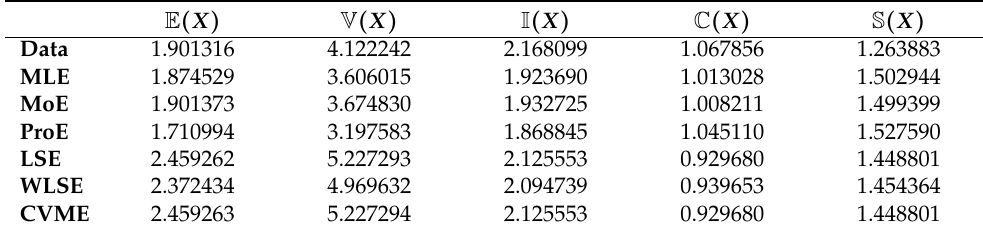
Table 17. Descriptive statistics for data set